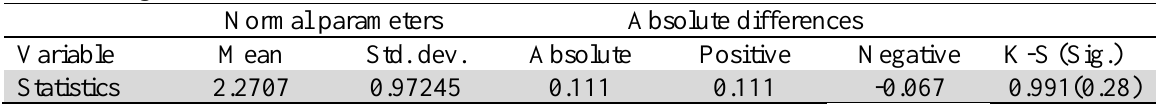
Test Kolmogorov – Smirnov